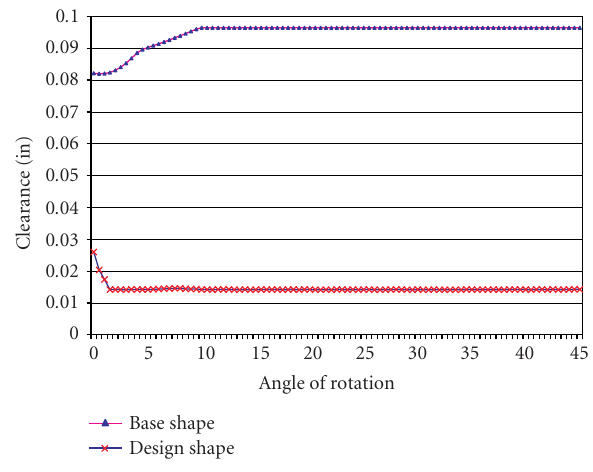
Figure 5: Minimum clearance with base shape and design